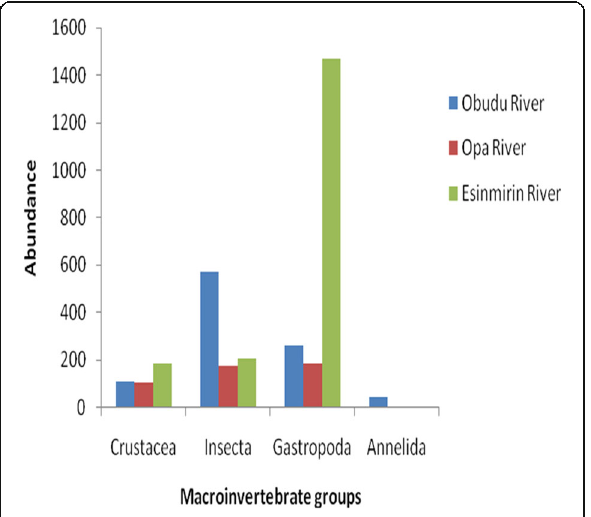
Fig. 4 Abundance of dominant groups of macroinvertebrates